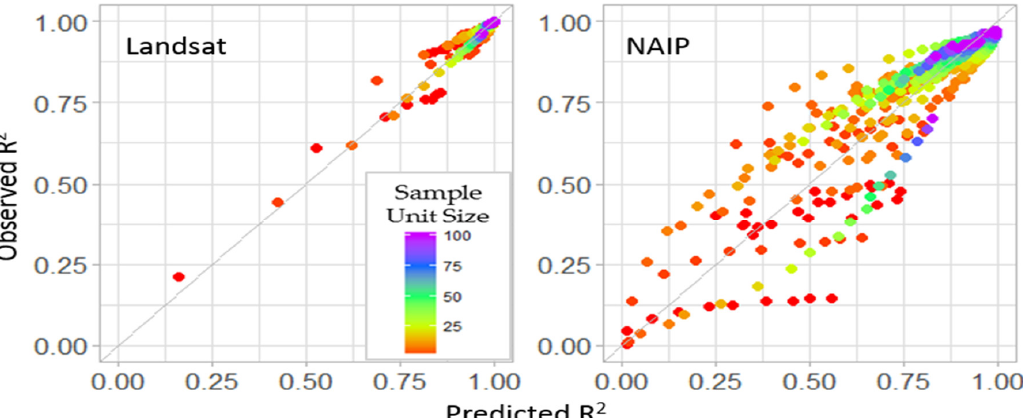
Figure 10. Observed versus predicted proportion of variance explained ( R 2 ) for co-registration errors associated with Landsat 8 and NAIP imagery and virtual imagery, given various sample unit sizes, measures of spatial correlation, and top-fitting beta regression models. The gray diagonal line is a one-to-one reference line.